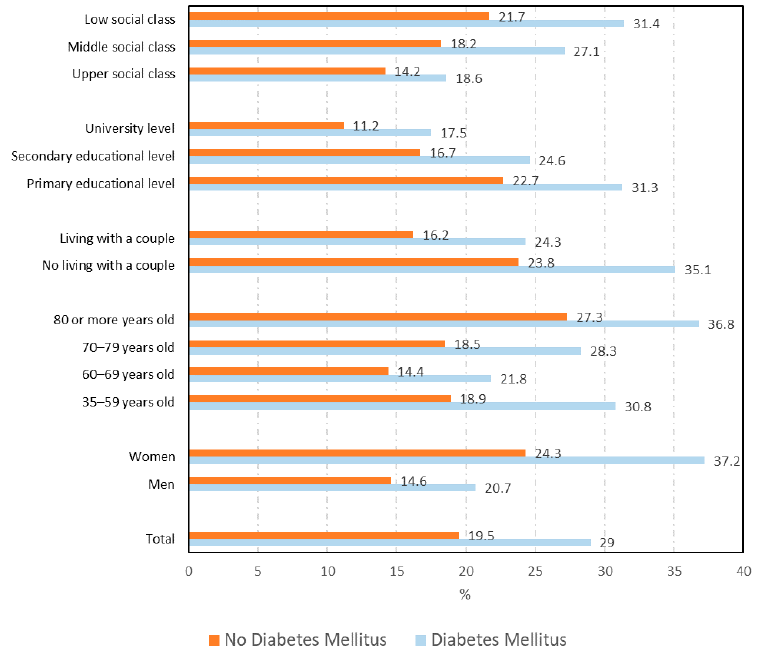
Figure 2. Prevalence of psychological distress according to sociodemographic variables among diabetes mellitus cases and controls.